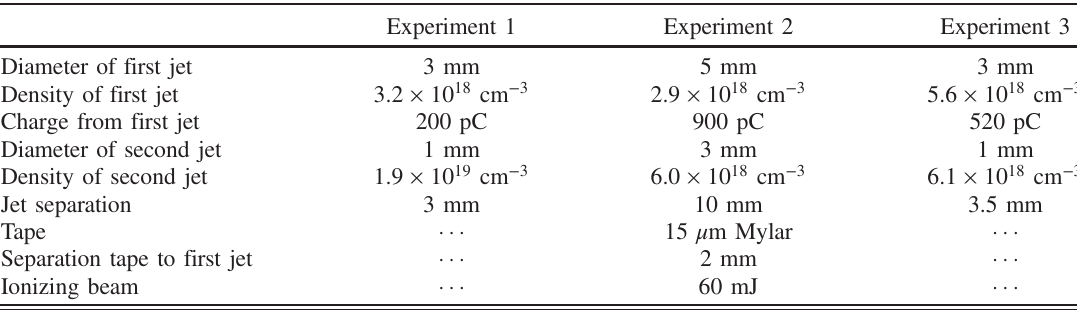
TABLE I. Configurations for Experiments 1, 2, and 3. The uncertainties of the densities are (cid:3) 0 . 4 × 10 18 cm − 3 . The charge is measured in the interval between 25 and 400